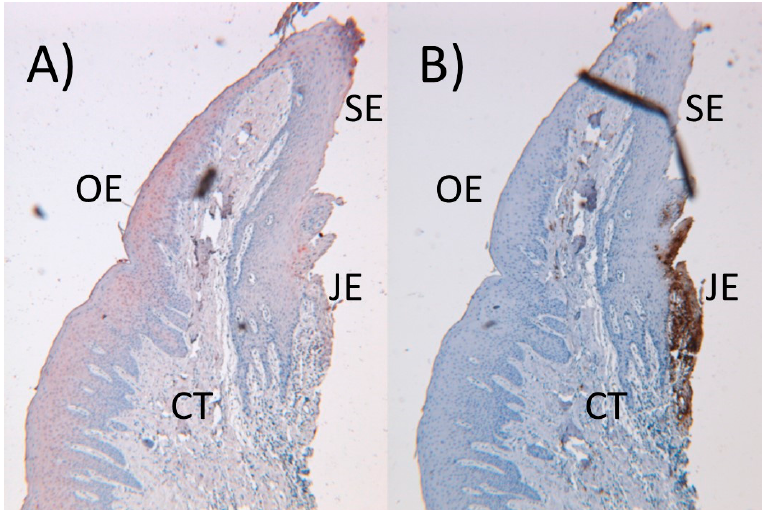
Figure 2. In a healthy gingiva, epithelial defensins (human β -defensins (hBD-2) in red color) are located in the oral (OE) and sulcular (SE) epithelia ( A ), while neutrophilic antimicrobial peptides ( α -defensins in brown color) are located in the junctional epithelium (JE) and partly in connective tissue (CT) ( B ). (An original figure by U.K.G.)